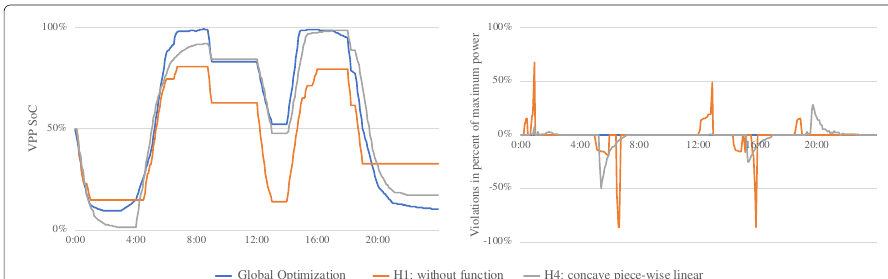
Fig. 4 Results of performing the optimization once for one day: The results from performing a single optimization step of one day are the basis for the proposed framework for managing the BESS. The results are illustrated for the global optimization as the baseline, heuristic 1 without any f char / dischar modeled and heuristic 4 with a concave piece-wise linear model. The optimal solution clearly exploits the VPP SoC more than the heuristic (zero violations, since all BESS can follow the control). Without any function modeled, a substantial part of the charging and discharging control cannot be implemented by the individual BESS. As shown in the figure on the right, up to 90% of a control can not be met. This hinders using the full range of VPP capabilities. Considering a concave piece-wise linear model reduces the violations and also allows to exploit the VPP better. But note that next only the first control decisions are implemented and therefore, the later violations are not that